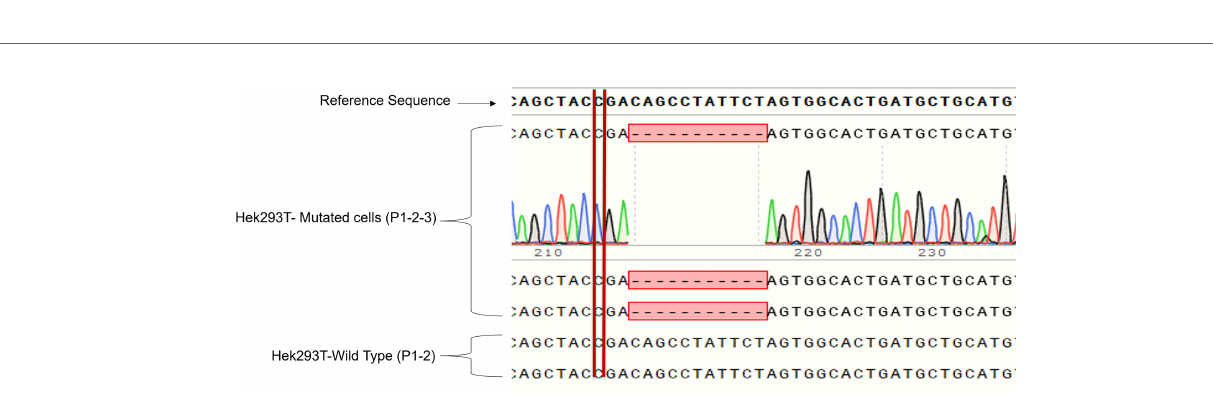
Frontiers in Endocrinology |